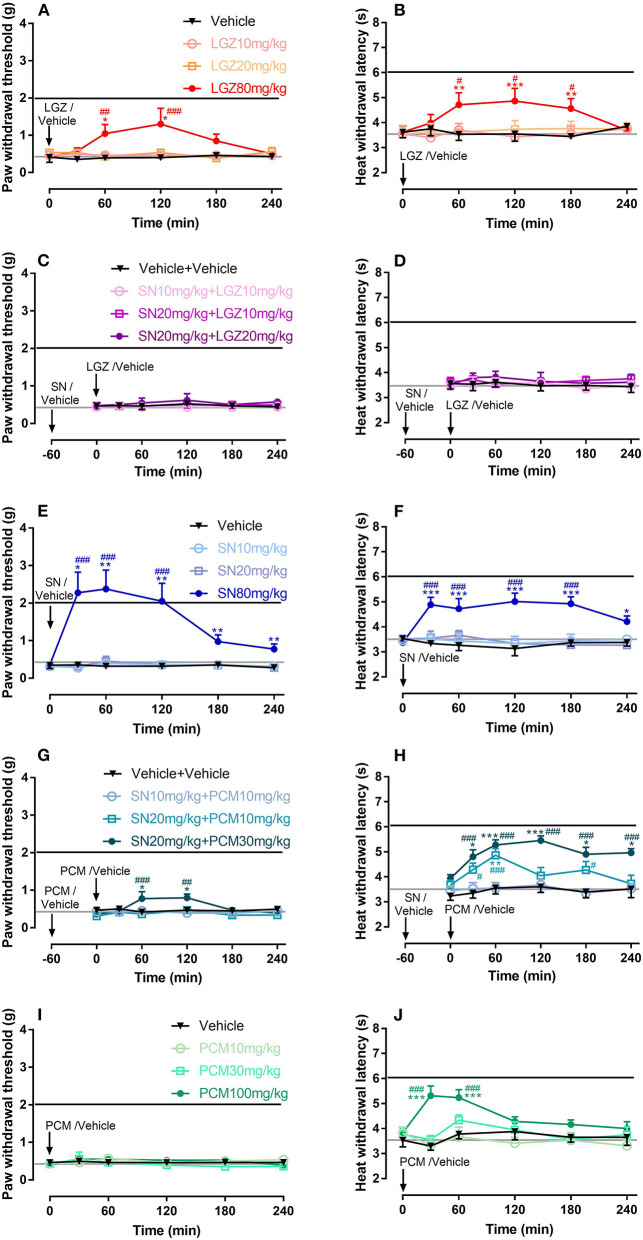
Dose dependent effects of LGZ (A,B), SN (E,F), PCM (I,J); and SN combined with LGZ (C,D) or PCM (G,H) on mechanical and heat hypersensitivities in mice with carrageenan induced inflammatory pain. N = 6–8 mice, data were presented as mean ± SEM. Black or Gray lines represent the average (mechanical/heat) thresholds before or 1 day after carrageenan injection, respectively. LGZ was applied at the dosages of 10, 20, and 80 mg/kg (A,B); SN was applied at the dosages of 10, 20, and 80 mg/kg (E,F); PCM was applied at the dosages 10, 30, and 100 mg/kg (I,J); SN (at 10 or 20 mg/kg) were applied 60 min before LGZ (at 10 or 20 mg/kg; C,D), or PCM (at 10 or 30 mg/kg; G,H) administrations. Mechanical/heat thresholds were measured for 240 min after completion of drug applications. Two Way ANOVA with repeated measures indicated overall significant differences (P < 0.05) between the groups (A,B,E,F,G,H,J). *P < 0.05, **P < 0.01, ***P < 0.001, post-drug thresholds were compared with pre-drug baselines at 0 min, using Dunn's (A,C,E,G,I) or Dunnett's (B,D,F,H,J) multiple comparisons test following ANOVA; #P < 0.05, ##P < 0.01, ###P < 0.001, post-drug effects were compared with controls (vehicle treatments) at each time points, using Bonferroni's multiple comparisons test following ANOVA.